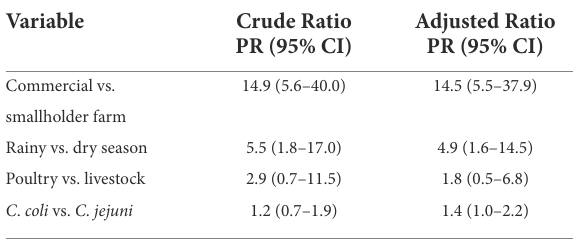
TABLE 4 Associations with the probability of having multidrug- resistant Campylobacter spp.